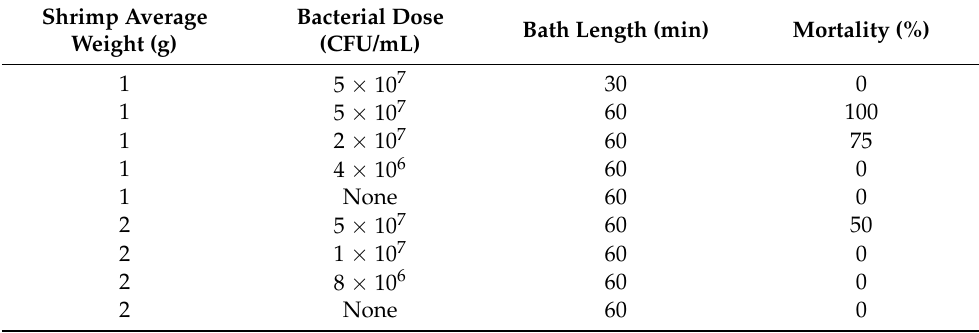
Table 2. Conditions assessed in the bath challenge model of shrimp with Vibrio parahaemolyticus ( Vp AHPND